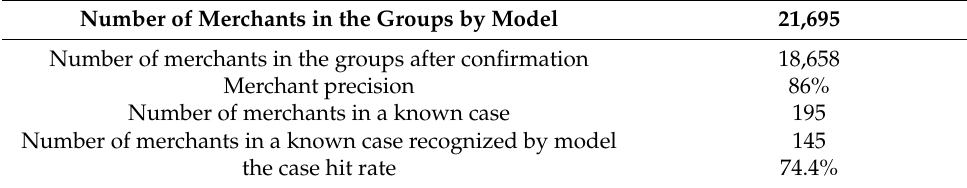
Table 6. Model effect of this model.